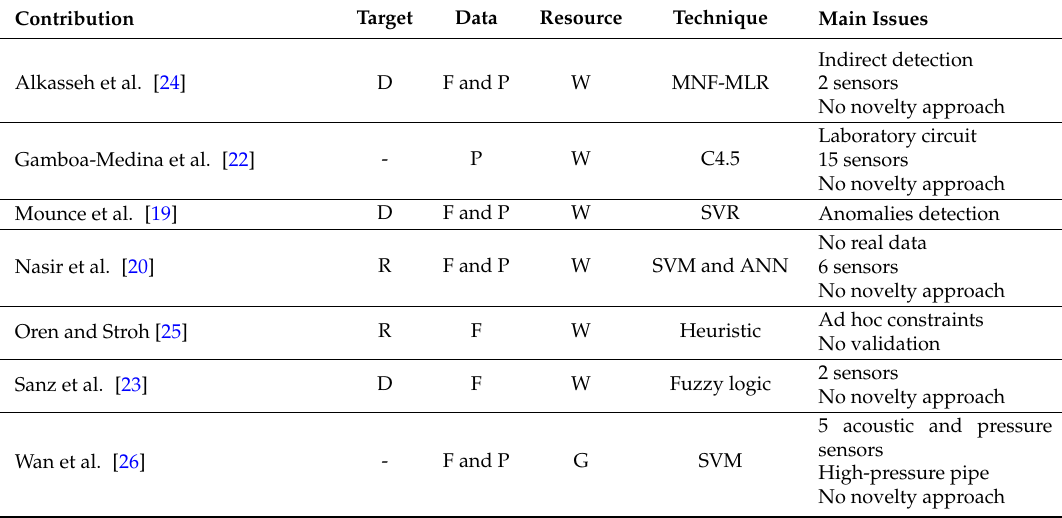
Table 1. Summary of the existing contributions in the leakage detection field and their characteristics. The “Target” columns report the target scenario, thus Residential (R) or District (D). The “Data” column reports the used data type, Flow (F) or Pressure (P), while the resource types, Water (W) or Gas (G), are reported in the column “Resource”. MNF, Minimum Night